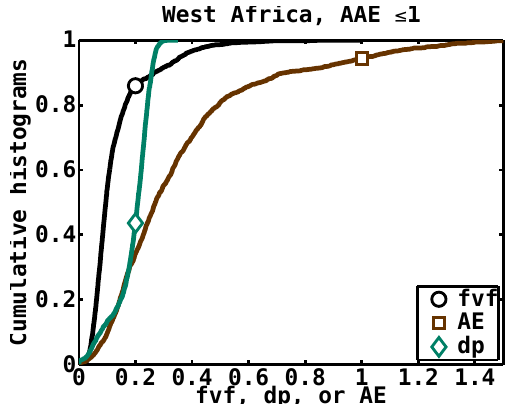
Figure 7. Absorption Ångström exponent (AAE) vs. fine volume fraction during the South American biomass burning season (gray circles) and at the West African sites (maroon squares). The South American data are limited to retrievals with more than 90% spheres. West African data with linear depolarization ratios greater than 0.2 are denoted by orange diamonds.